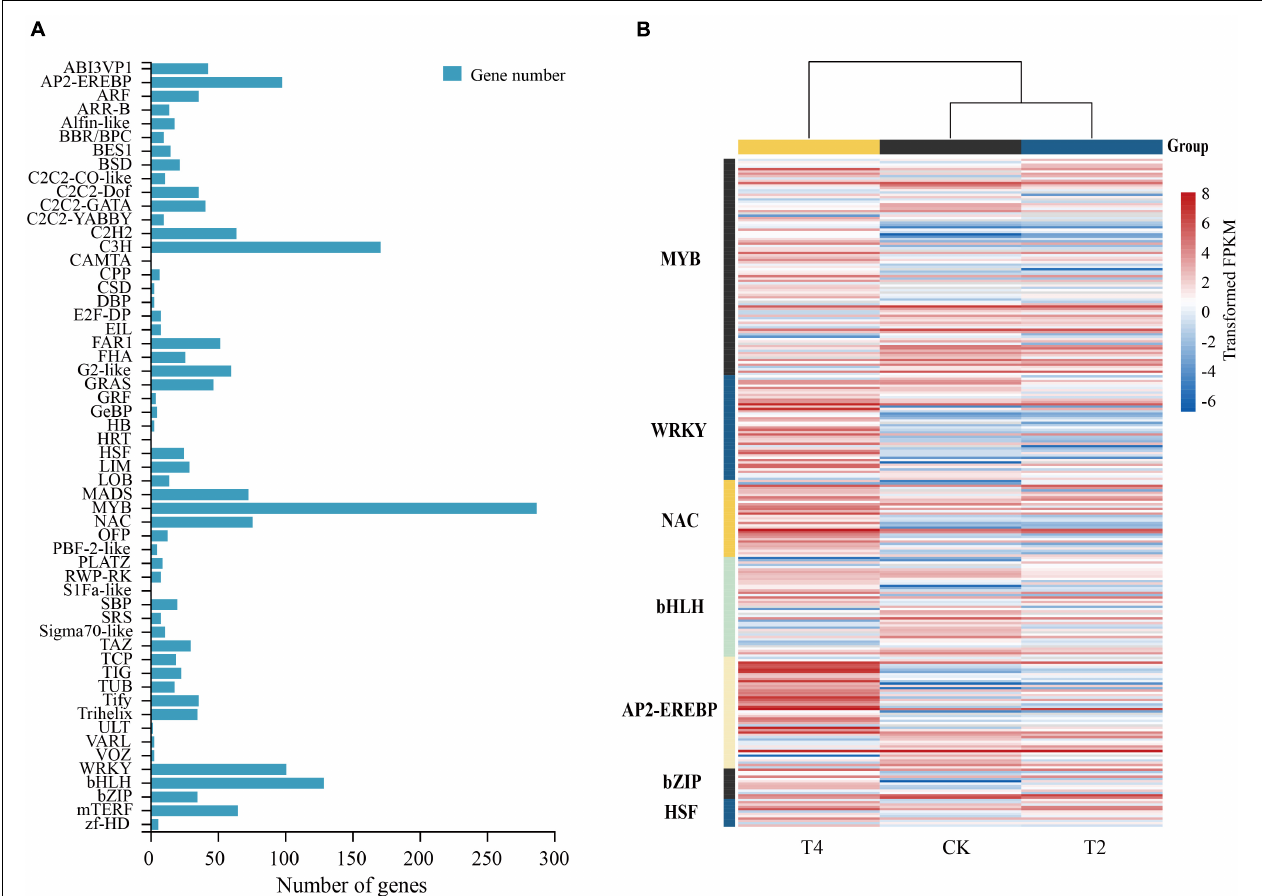
FIGURE 6 | Differential regulation of transcription factors in drought treatments. (A) The number of differentially expressed genes (DEGs) of transcription factors after drought treatment. (B) Heatmap of seven classes of transcription factors (MYB, WRKY, NAC, bHLH, AP2-EREBP, bZIP, and HSF) closely associated with drought; the heatmap shows log 2 FPKM values of the differentially expressed